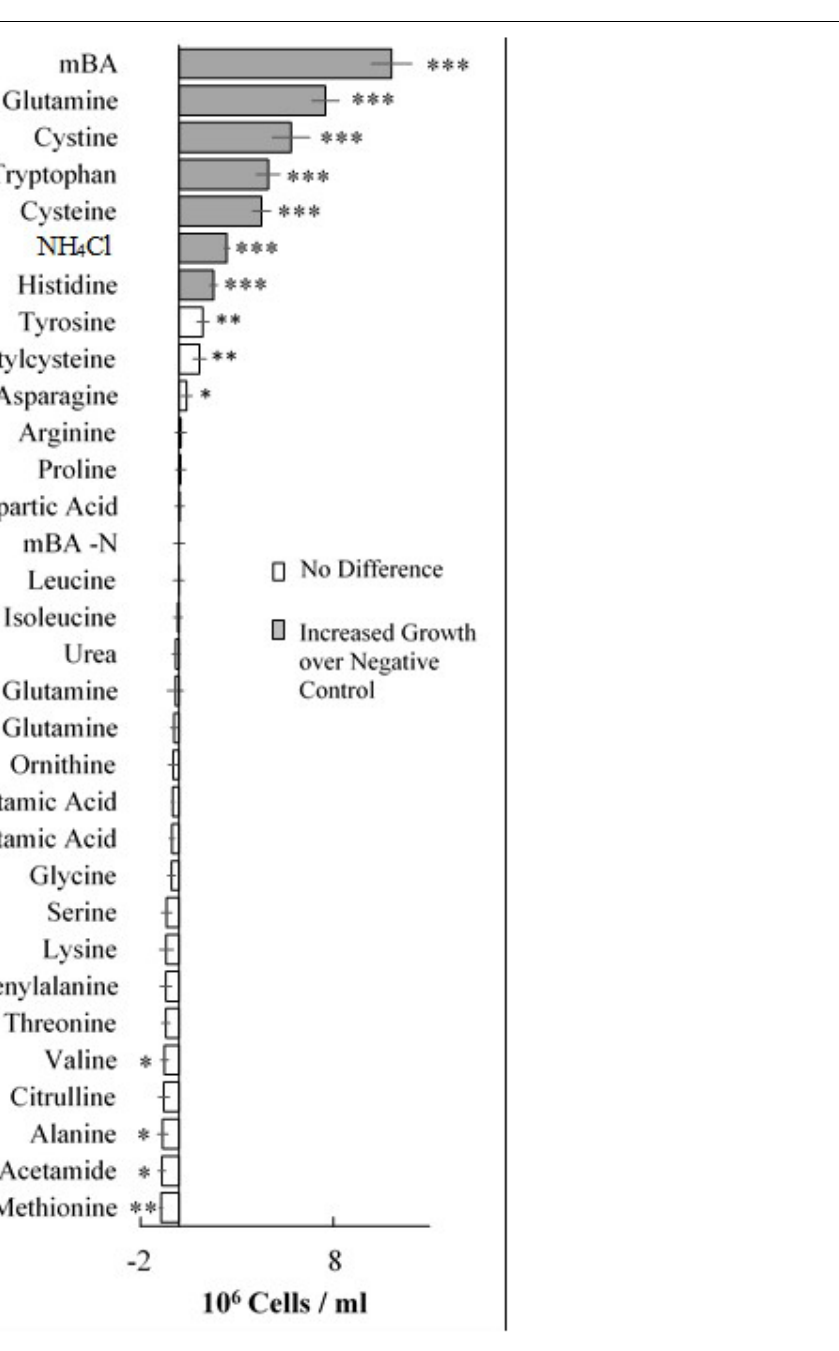
FIGURE 2 | Growth of Dunaliella viridis supplemented with nitrogen substrates. The difference in mean cell density between cultures grown on different nitrogen sources and a nitrogen starvation control (mBA -N) was analyzed. Cultures were grown for 144 h on mBA -N containing 5 mM of each the above nutrients (0.5 mM used for NH 4 Cl). Error bars represent one standard deviation. Significant differences relative to the unsupplemented mBA -N control was assessed using a two-tailed paired Student’s t -Test at p ≤ 0.05 ( ∗ ), p ≤ 0.01 ( ∗∗ ), and p ≤ 0.001 ( ∗∗∗ ). Four biological replicates were used for